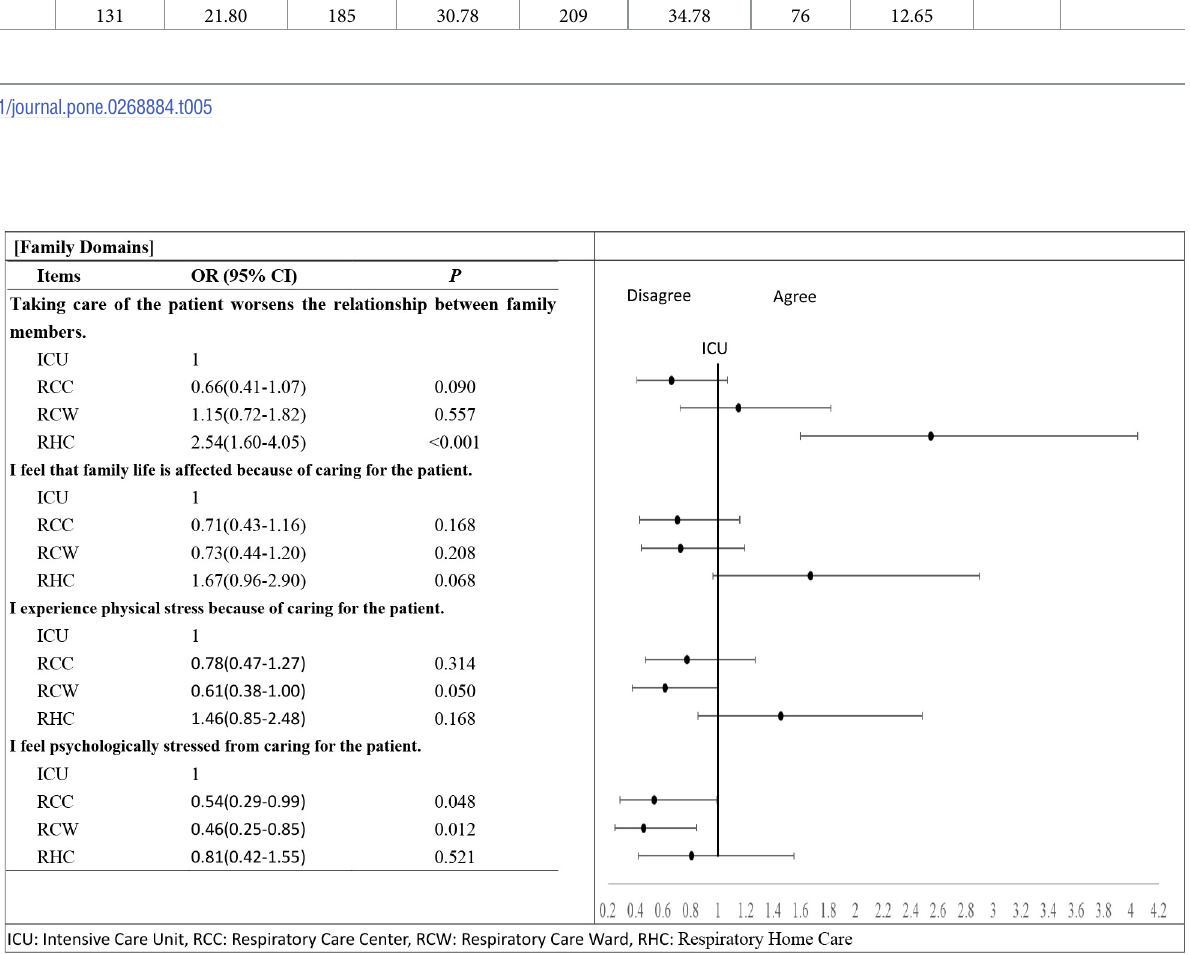
1 Chi-square test.